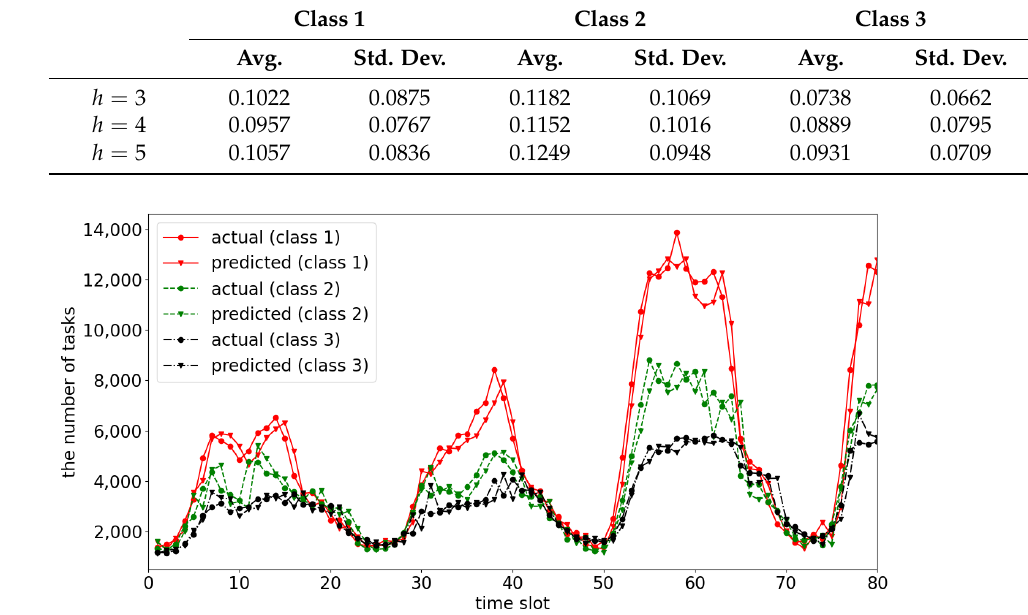
Table 2. Performance comparison of LSTM prediction in terms of RMS.